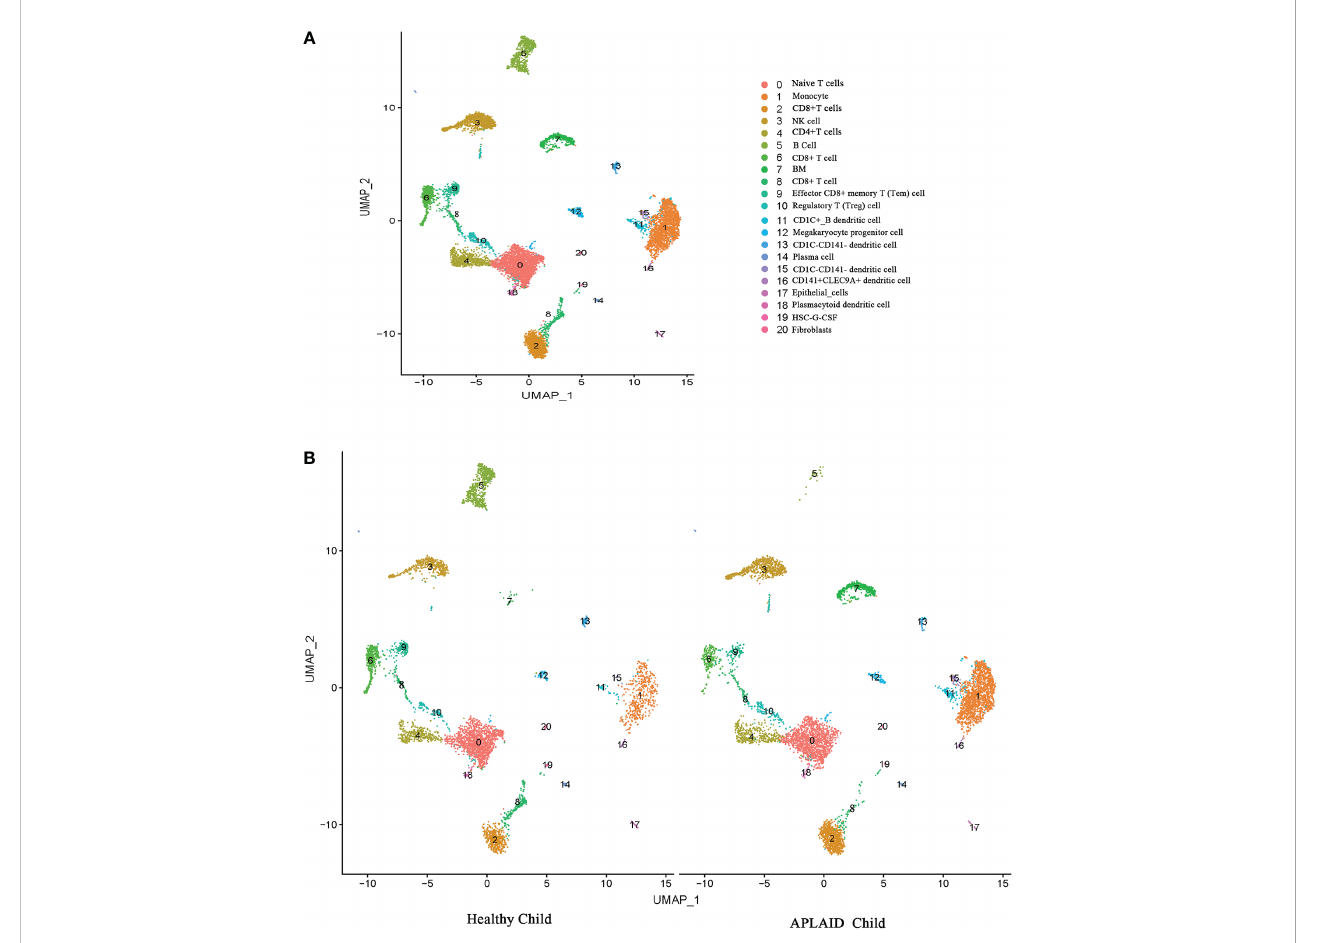
FIGURE 4 Cell types identi fi ed in peripheral blood mononuclear cells (PBMC) by uniform manifold approximation and projection (UMAP). Each dot represents a cell, which is colored according to cell type. (A) Merged cell clusters in two samples. (B) 21 cell clusters in healthy child (left) and APLAID child (right) PBMC samples,